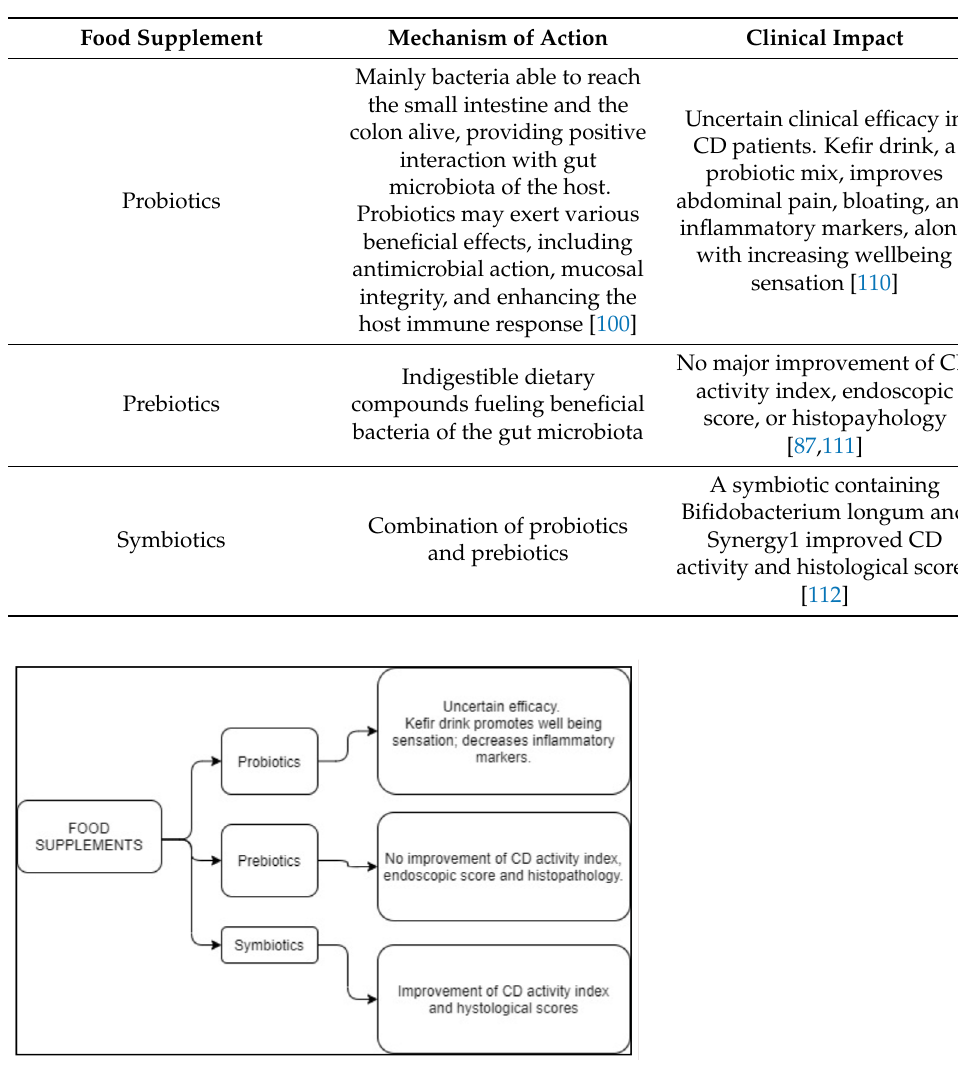
Table 2. Summary of the main features related to prebiotics, probiotics, and symbiotics.